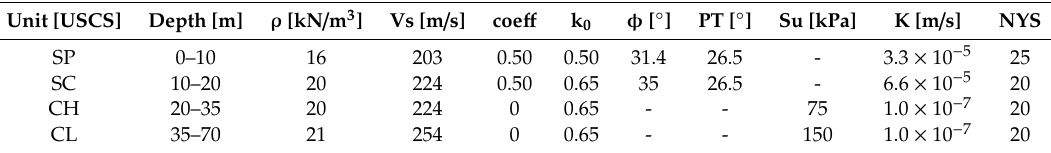
Table 6. Model parameters for the Lo Rojas site.